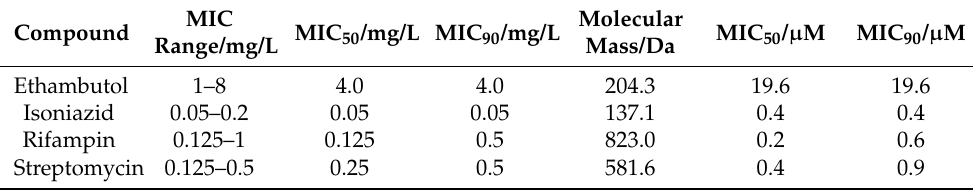
Table 7. Experimental MIC of the selected compounds against MTBC.